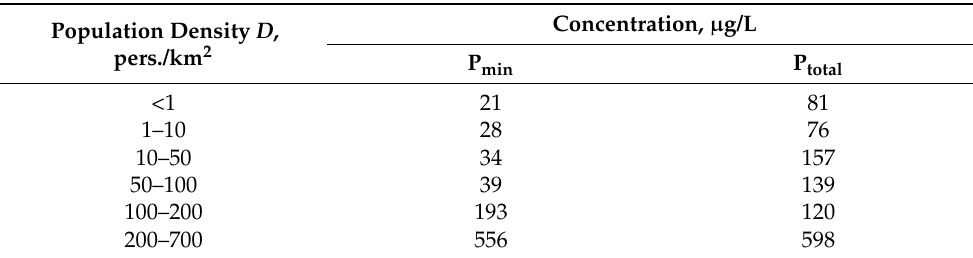
Table 11. The average content of dissolved phosphorus in the water of rivers with different population densities in their catchments